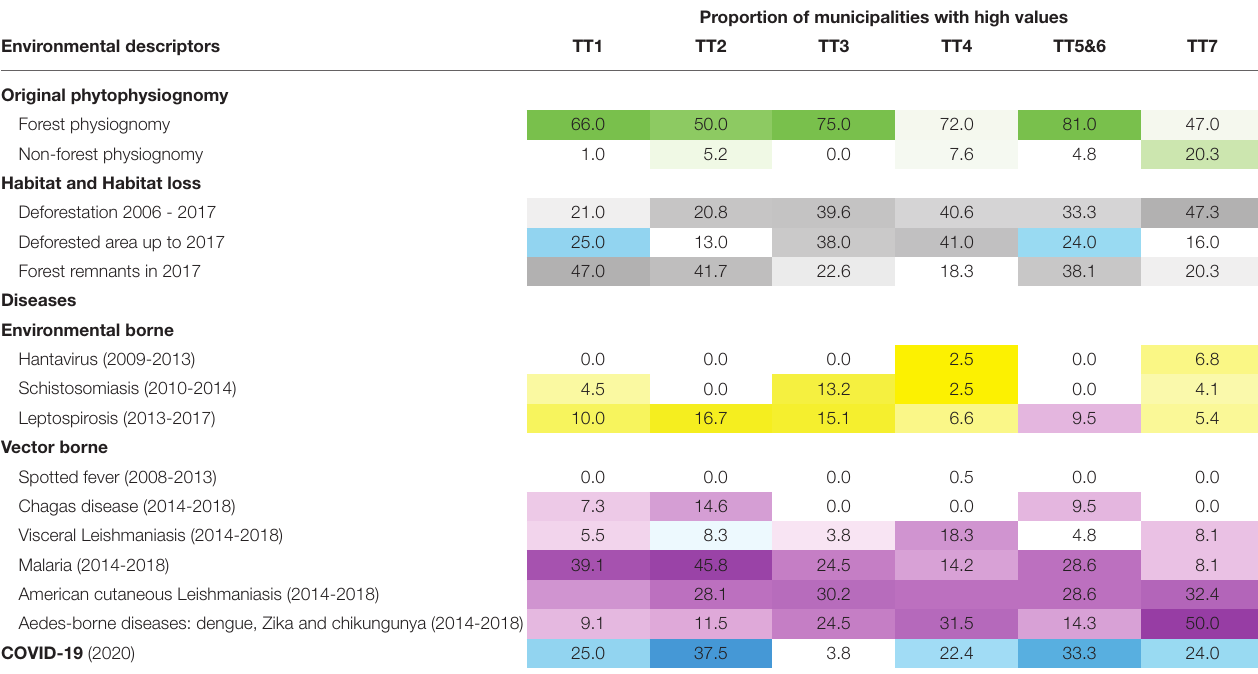
TABLE 2 | The values correspond to the percentage (%) of municipalities following a techno-productive trajectory classified as presentng “high values”. Proportion of municipalities with high